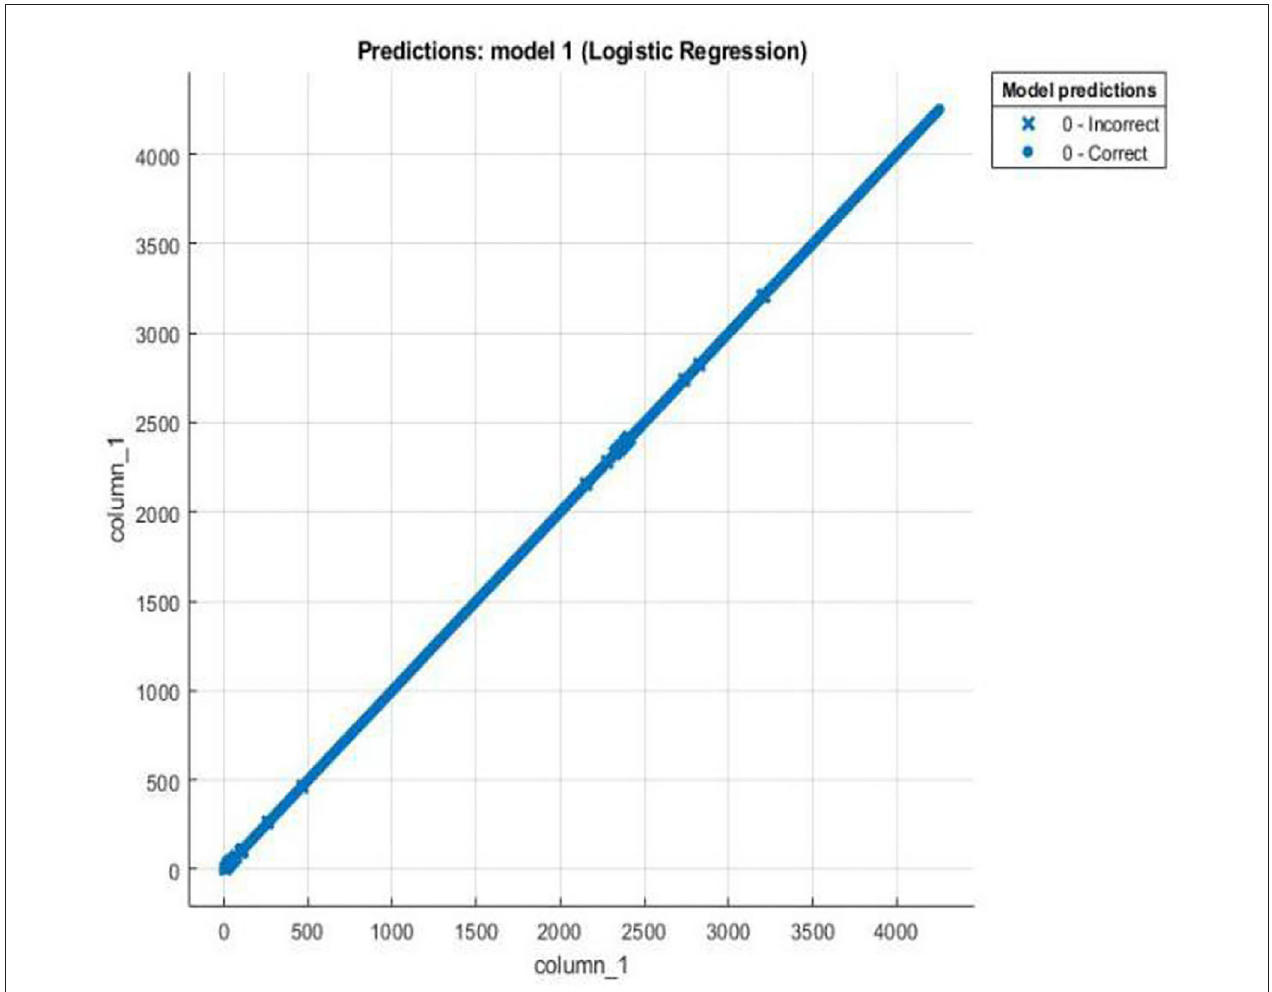
FIGURE 7 | Scatter plot from logistic